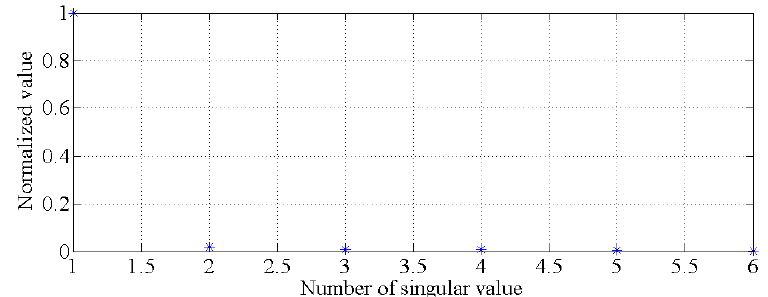
Figure 8. Singular values for determining the principal components.